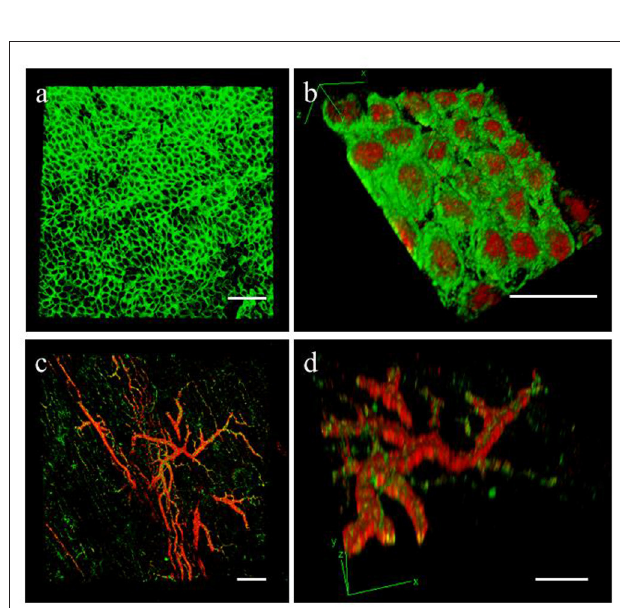
FIGURE 6 | Epicardial slices decolouration. Immunohistochemical staining and confocal analysis 3D reconstruction of decolorized epicardial slices obtained from piglet hearts, showing (a) low magnification image of the epicardial layer stained with MSLN (green) and (b) high magnification image showing the epicardial monolayer stained with MSLN (green) and WT1 (red) from the bottom. Low magnification (c) and detail view (d) of the vasculature present into the epicardial slice a stained with smooth muscle marker α -SMA (red) and the endothelial marker CD31 (green). Scale bars, 50 µ